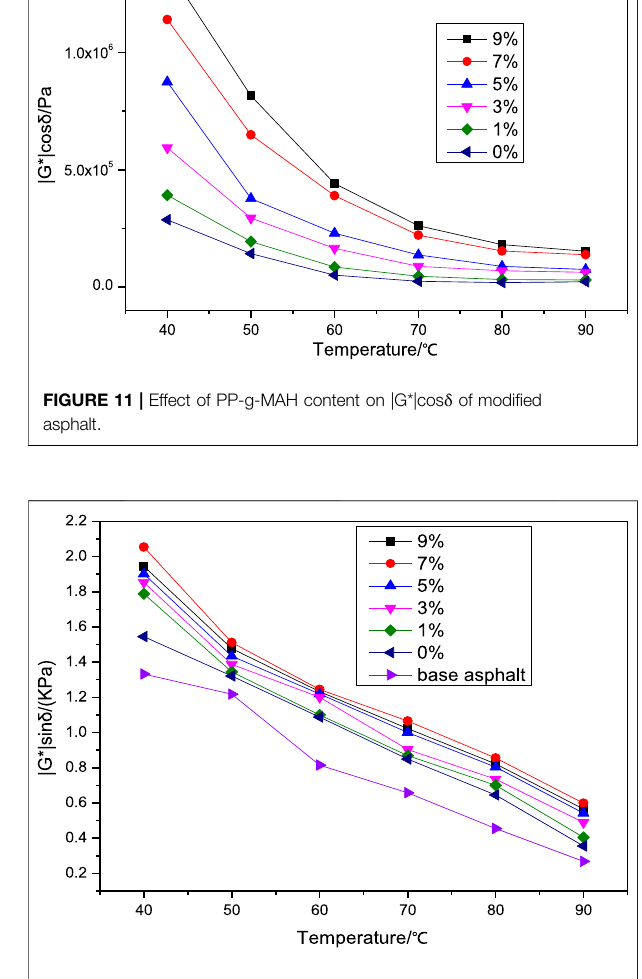
FIGURE 12 | Effect of PP-g-MAH content on |G*|sin δ of modi fi ed